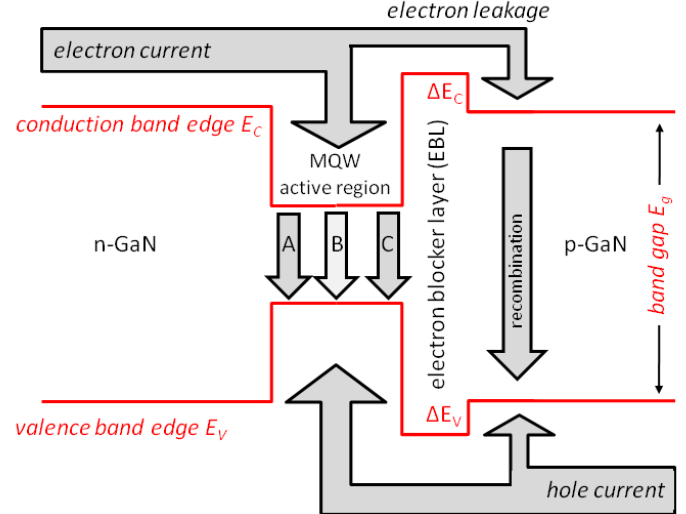
Figure 2. Illustration of the vertical LED energy band diagram including current flow and electron–hole recombination processes (A—defect-related recombination, B—photon emission, C—Auger recombination) [4]. Multiple quantum well (MQW) active regions typically consist of InGaN wells and GaN barriers. The electron blocker layer (EBL) is typically made of AlGaN.